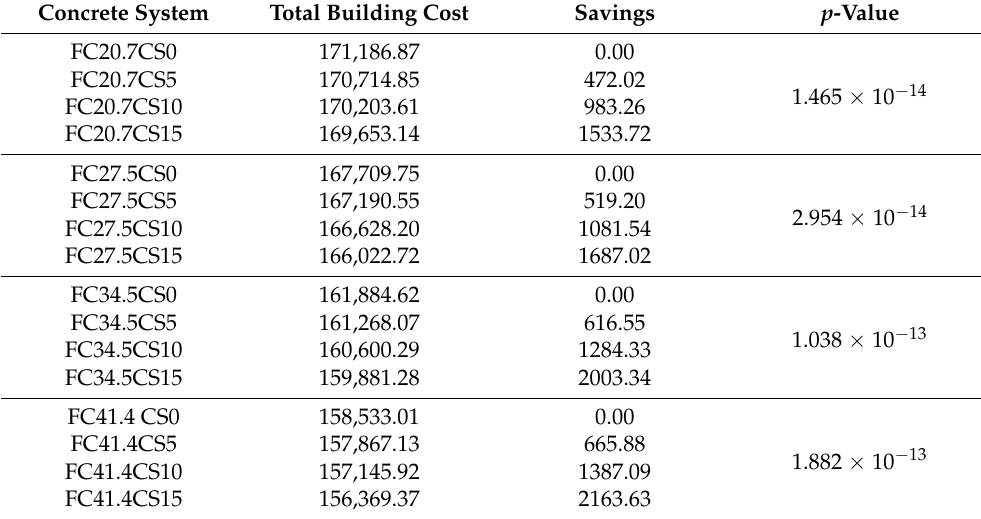
Table 13. Seven-story building cost and cost savings, along with corresponding p -value. Concrete